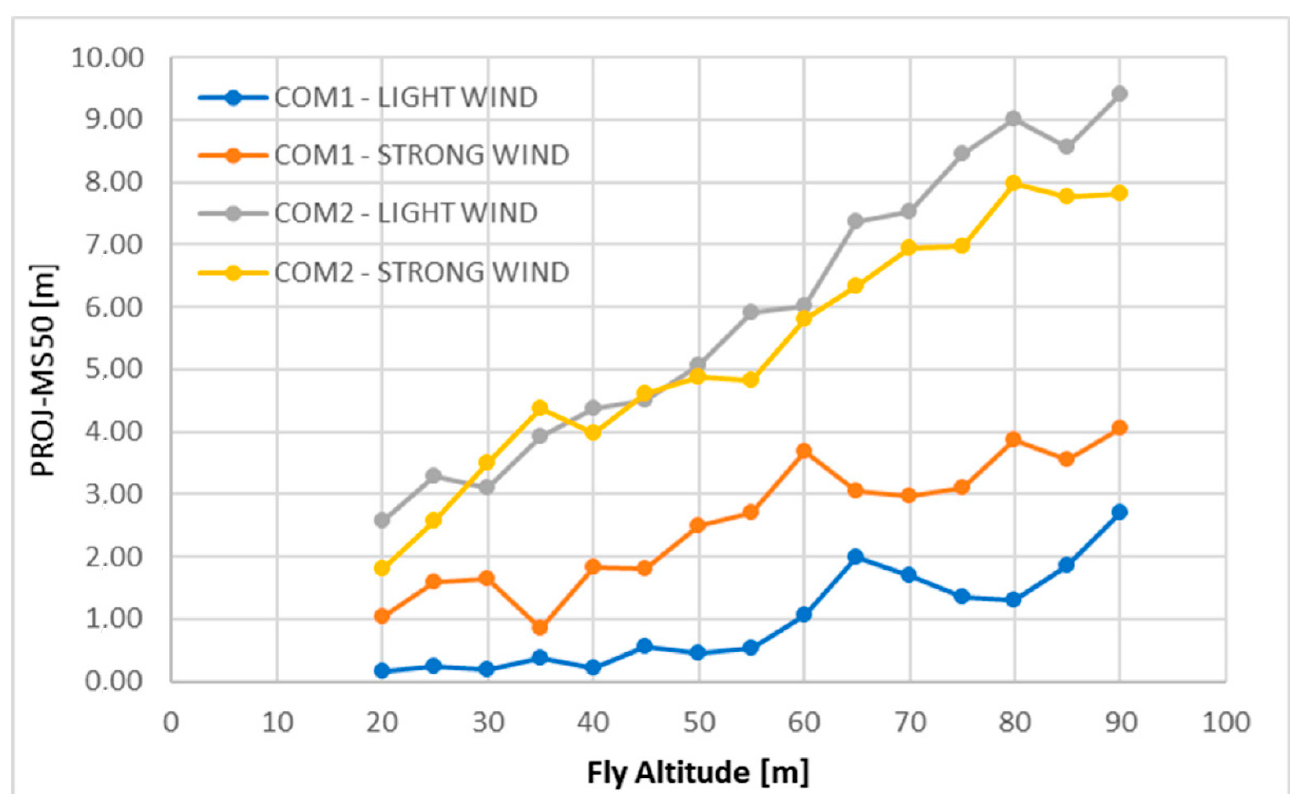
Figure 5. Recorded differences between design data (PROJ) and those captured by the Leica Nova MS50 instrument [48], used with permission under Creative Commons Attribution 4.0 International License.